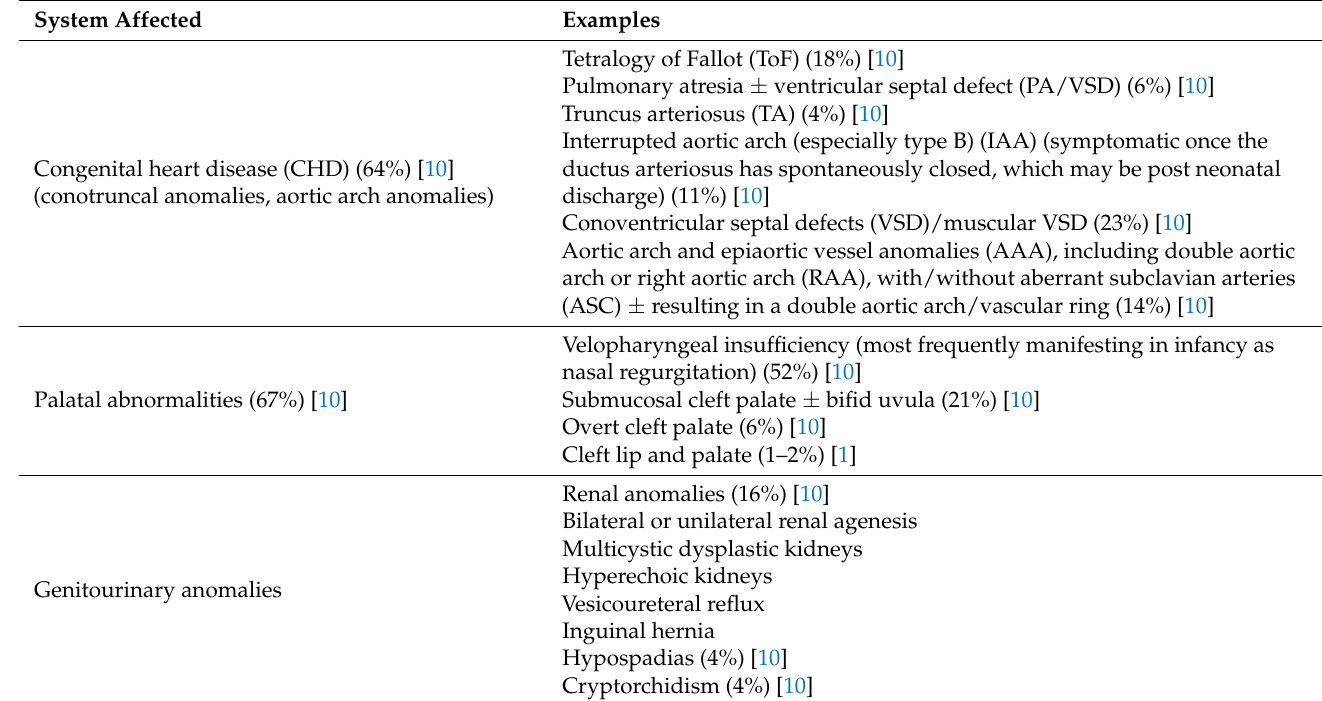
Table 1. Features of 22q11.2 deletions that may be evident prenatally, at birth, or soon